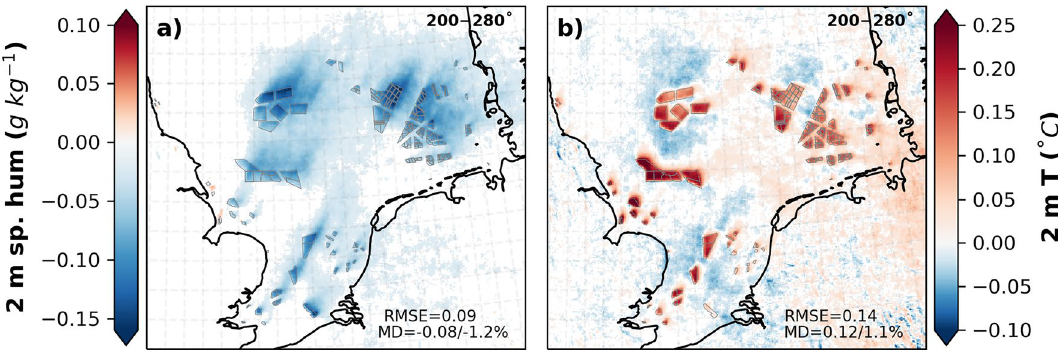
Figure 5. Annual mean difference between the CCLM_WF and CCLM in 2 m ( a ) specific humidity and ( b ) temperature outside and inside the wind farms for the prevailing wind directions of 200–280° in 2008–2017. Root mean square errors (RMSE) and mean differences (MD) over the wind farm areas in 2008–2017 are given in the legend. This figure was created with Matplotlib (Hunter, J. D., Matplotlib: a 2D graphics